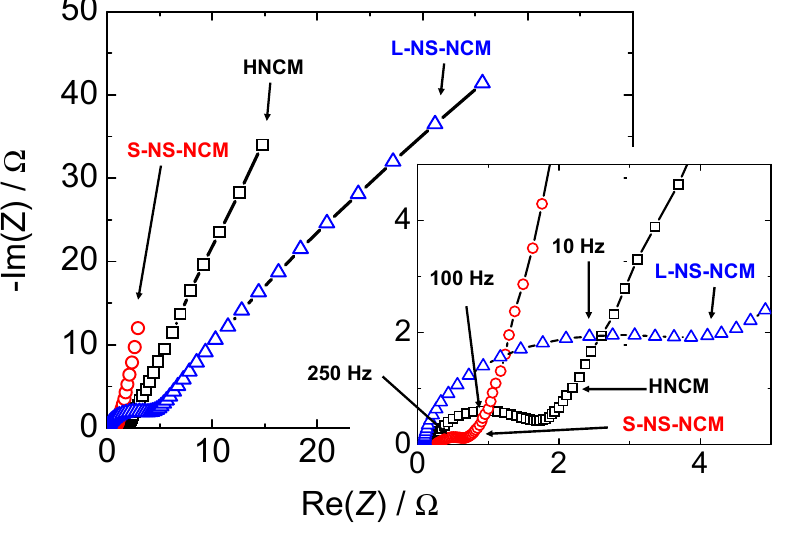
Figure 10. AC-impedance plots for HNCM, L-NS-NCM, and S-NS-NCM.